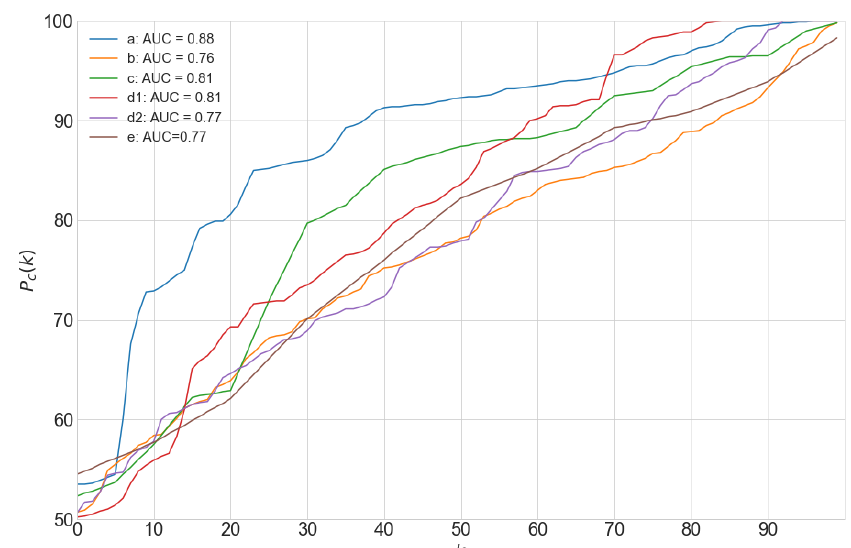
Figure 7. Percentile curves of maximum intersection I i for CMs i in M m , for all the analyzed images. Area Under the Curve (AUC) values are presented in the